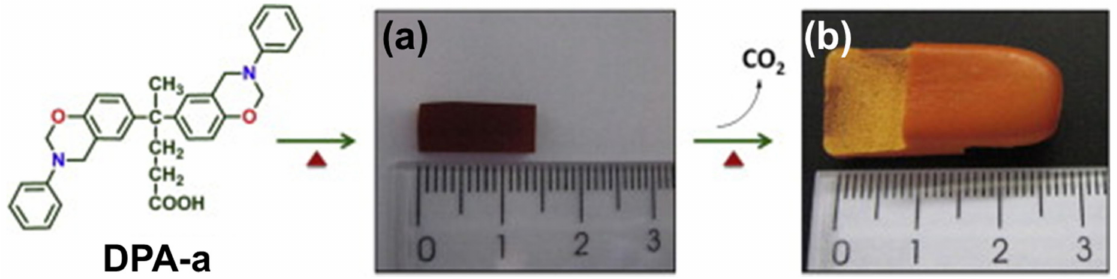
Figure 46. Thermal polymerization of DPA-a monomer. Photographs of ( a ) partially cured polybenzoxazine and ( b ) cross-section of polybenzoxazine foam after heating at 220 ◦ C [111]. Copyright 2012. Reproduced with permission from Elsevier